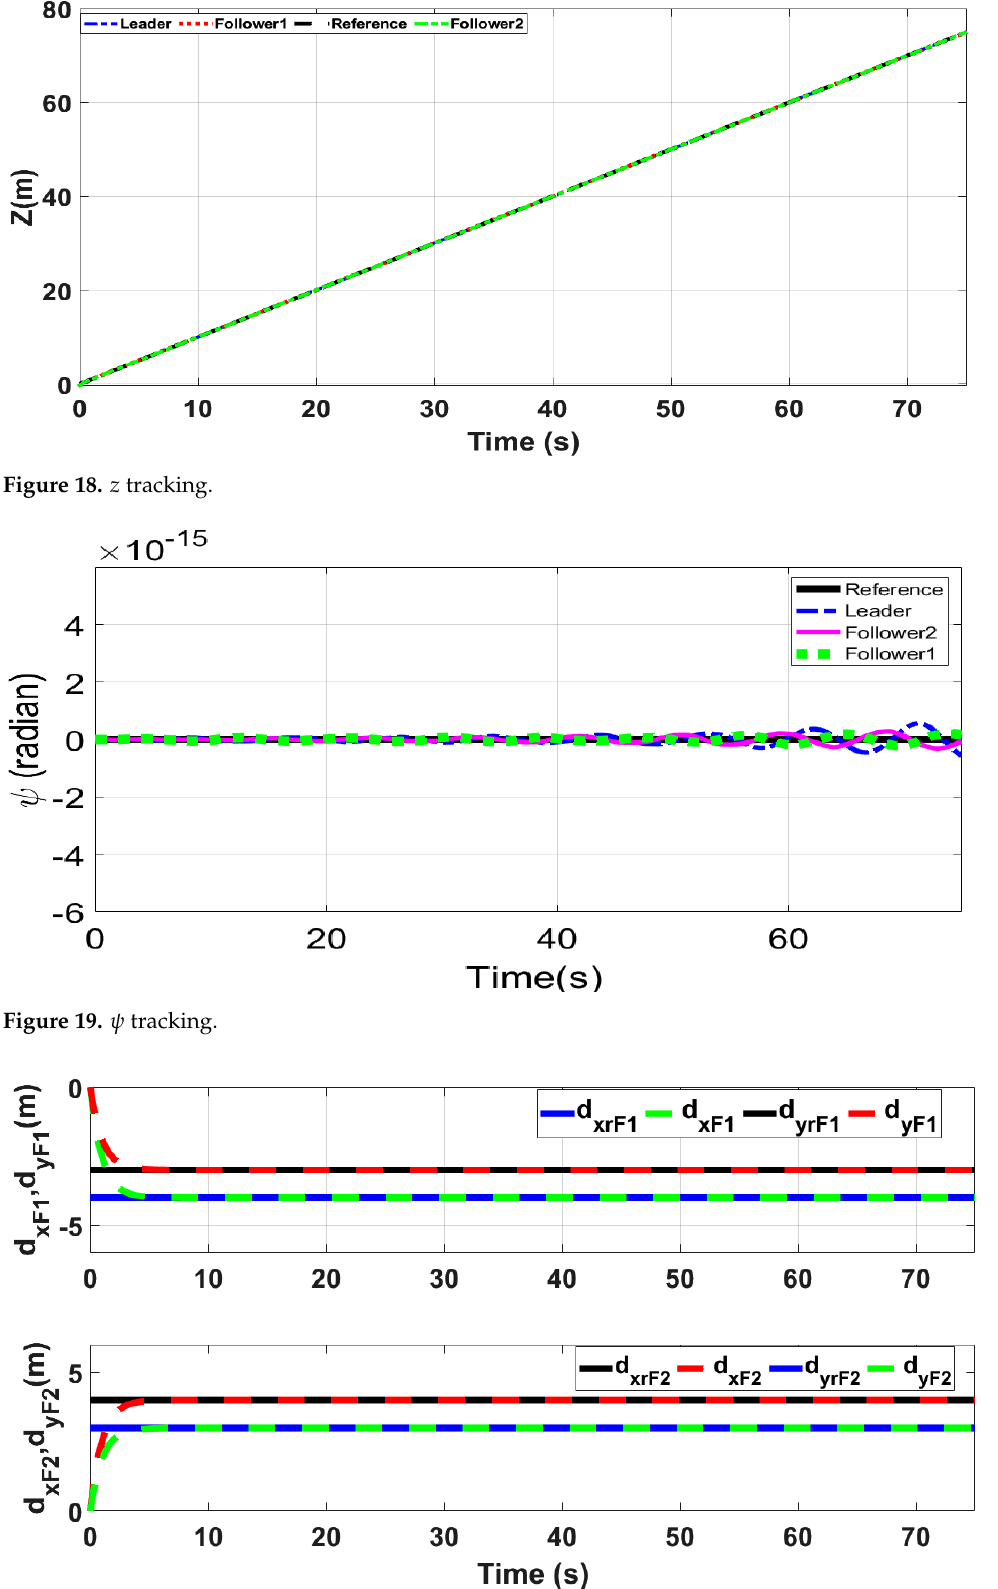
Figure 20. Formation controller